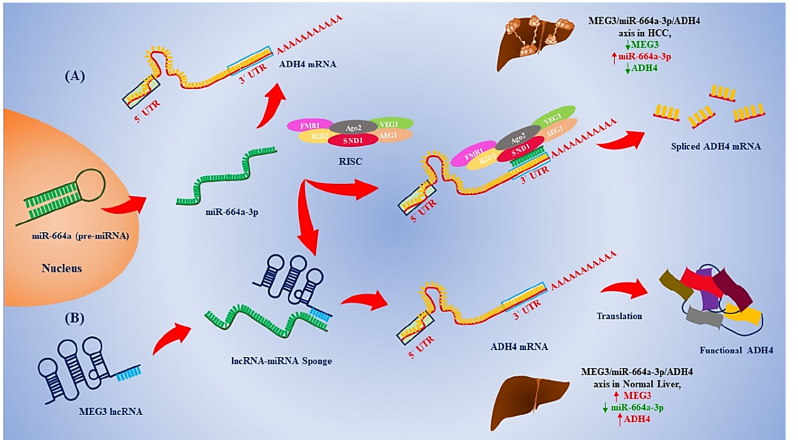
Figure 6. The overall mechanism of MEG3/miR-664a-3p/ADH4 axis. ( A ) In normal liver, MEG3 acts as a competitive molecular sponge for miR-664a-3p and prevents miR-664a-3p-mediated RISC targeting and degradation of ADH4 mRNA. ( B ) In HCC, MEG3 is downregulated resulting in miR-664a-3p expression and binding to ADH4 mRNA, causing subsequent downregulation of ADH4 mRNA through RISC mediated cleavage of the mRNA.